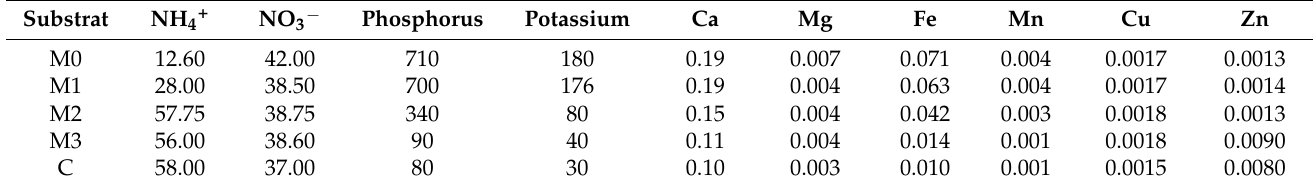
Table 2. The content of mineral elements in the different